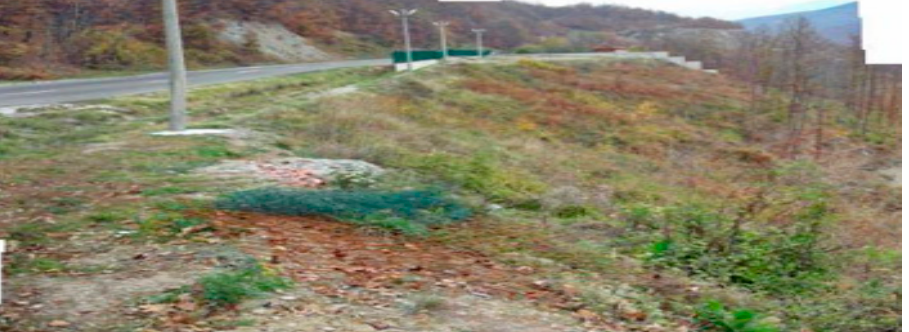
Figure 2. “Kominja 2” location on which the landslide is formed [23].